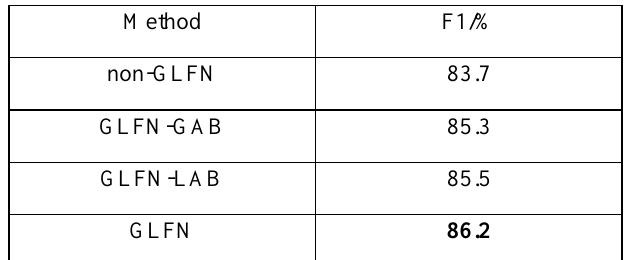
Table 3. The highest F1 values of four methods on